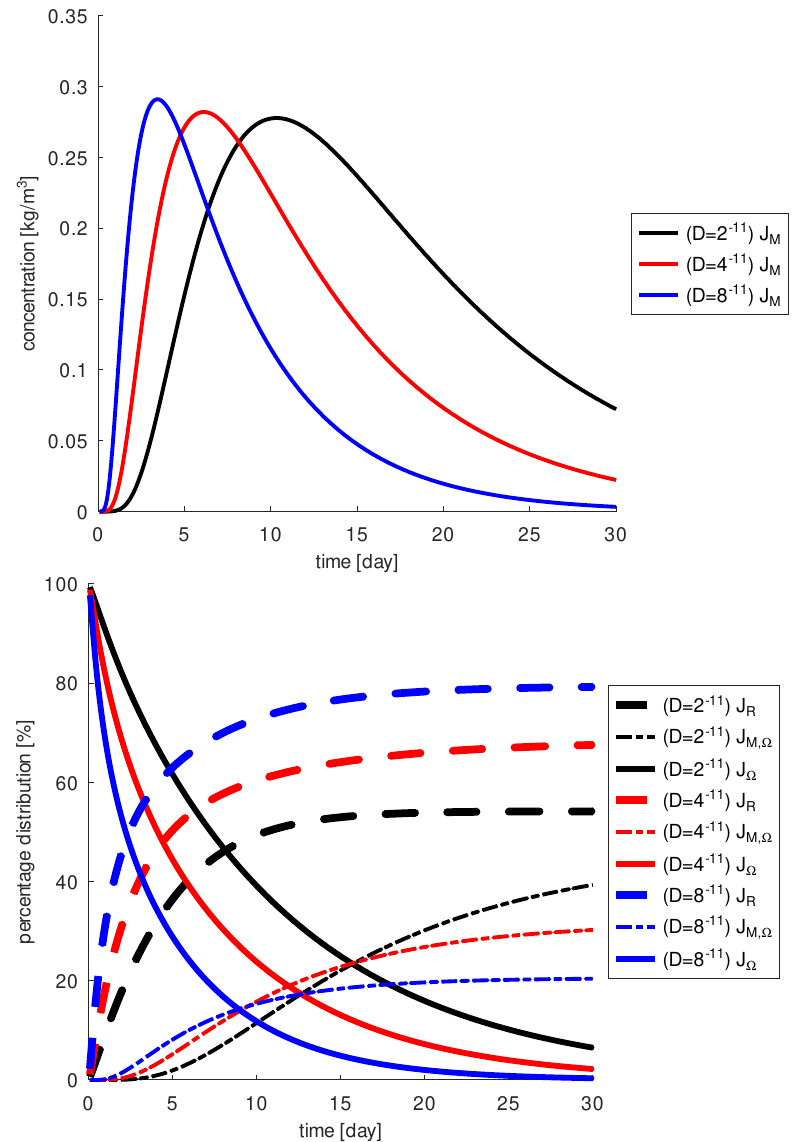
Figure 10. Top: the drug amount at the macula, J M , as a function of D , lighter molecules (blue) are faster; bottom: the drug amount in the vitreous, J Ω , at the macula, J M , Ω , and lost through the retina, J R , in dependence of D . Heavier molecules remain longer in the vitreous, the loss through the retina is less than for lighter and faster molecules, and more of them finally reach the macula after 17 days, in the first 8 days more lighter molecules reach the macula and between 8 and 16 days more intermediate weight molecules reach the